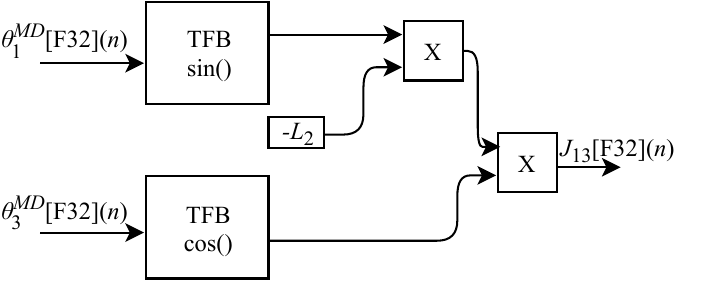
Figure 23. Proposed circuit to calculate the Jacobian matrix J 13 [ F 32 ]( n ) (Equation (35))—JM.